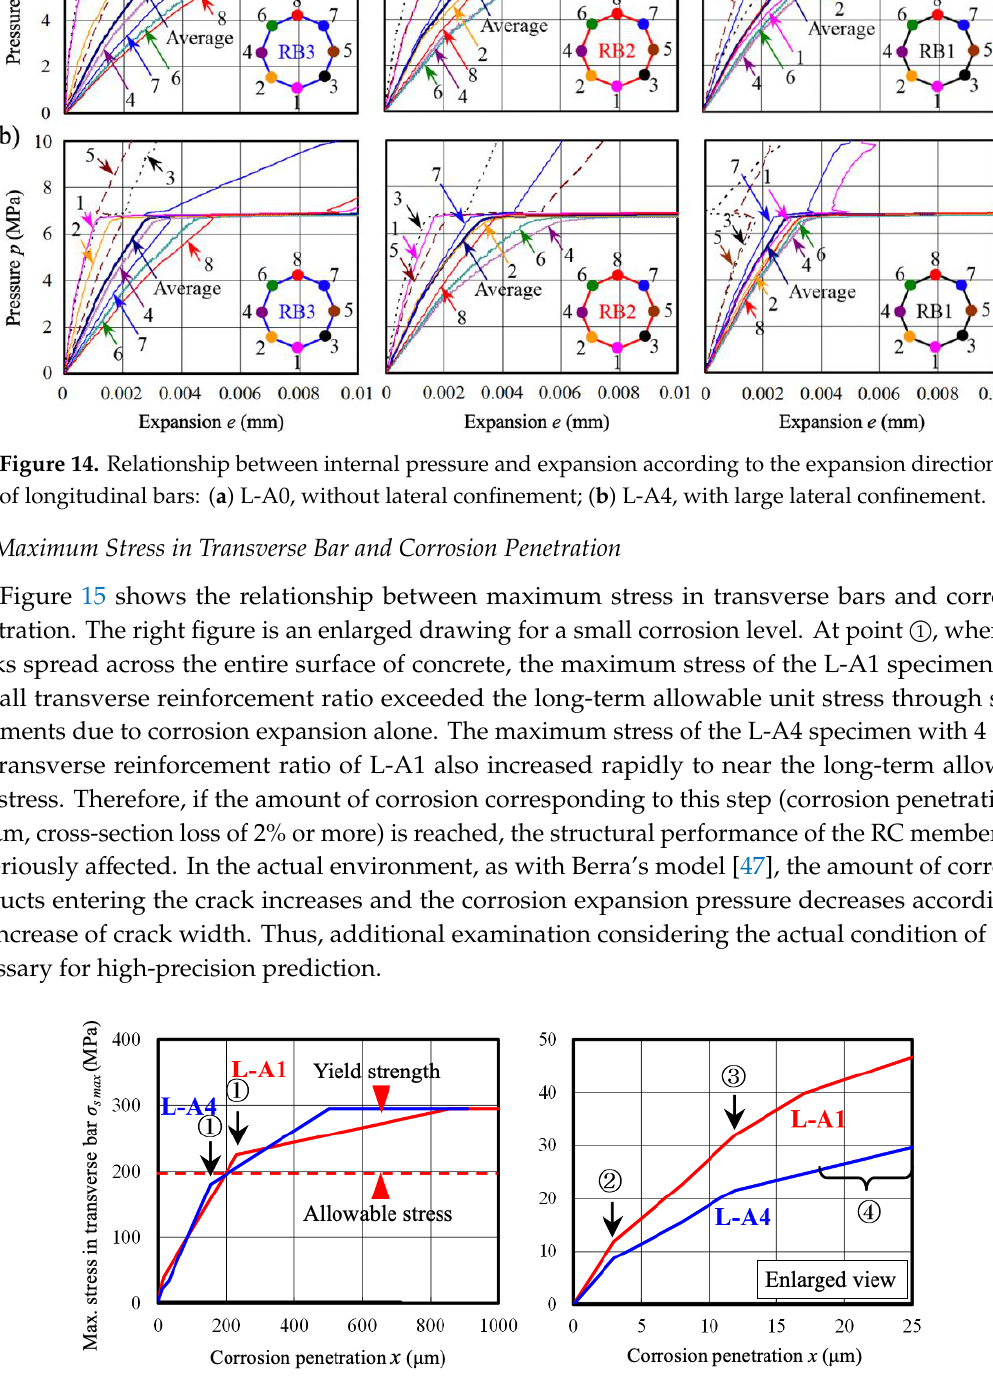
Figure 15. Relationship between maximum stress in transverse bars and corrosion penetration.